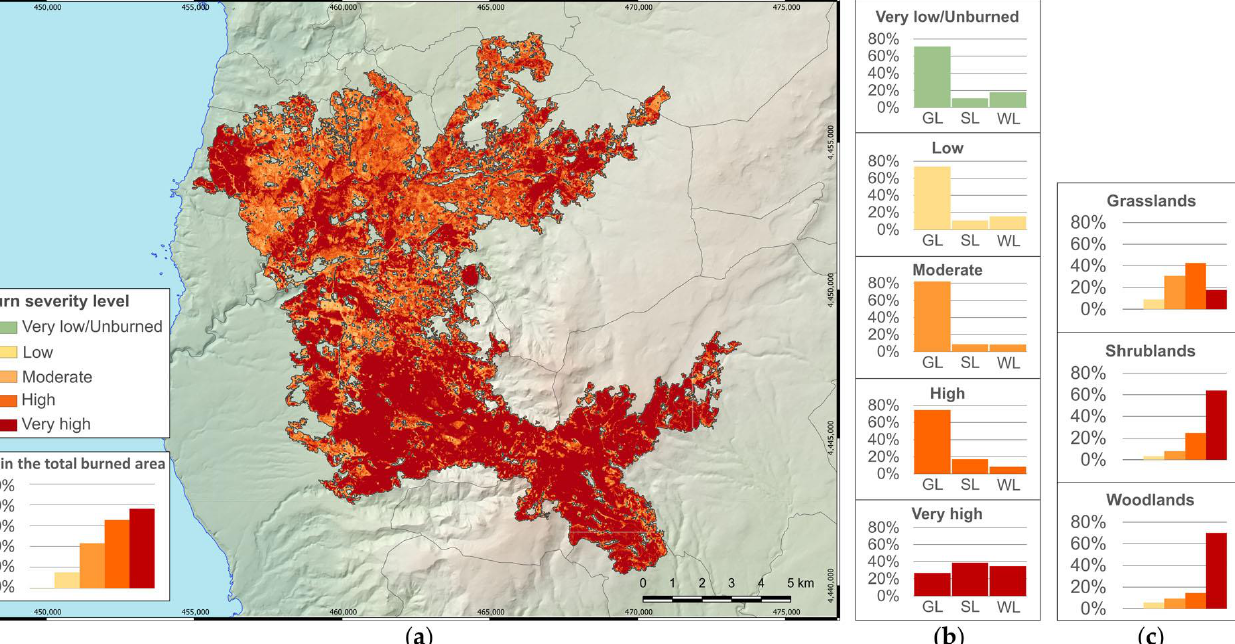
Figure 3. Boxplot of dNBR pre-post values in burned and unburned grasslands (GL), shrublands (SL), and woodlands (WL). The boxes show the interquartile range, horizontal bars show median values, and vertical bars show the top and bottom 25% quartiles. 3.2. Short-Term Vegetation Response 3.2.1. Vegetation Recovery at Landscape Scale Assessed with Multispectral Data Figure 4 shows the burn severity levels one year after the fire and illustrates the gap still occurring between the current and the pre-fire condition of the vegetation in terms of dNBR values (i.e., dNBR pre-1yr ). Very high and high severity levels are greatly resized, covering 2.1% and 8.4% of the burned area, respectively. Moderate severity level covers 15.6% and low severity covers 21.8% of the burned area, while the unburned/very low severity level is now predominant, covering 52.0% of the burned area.